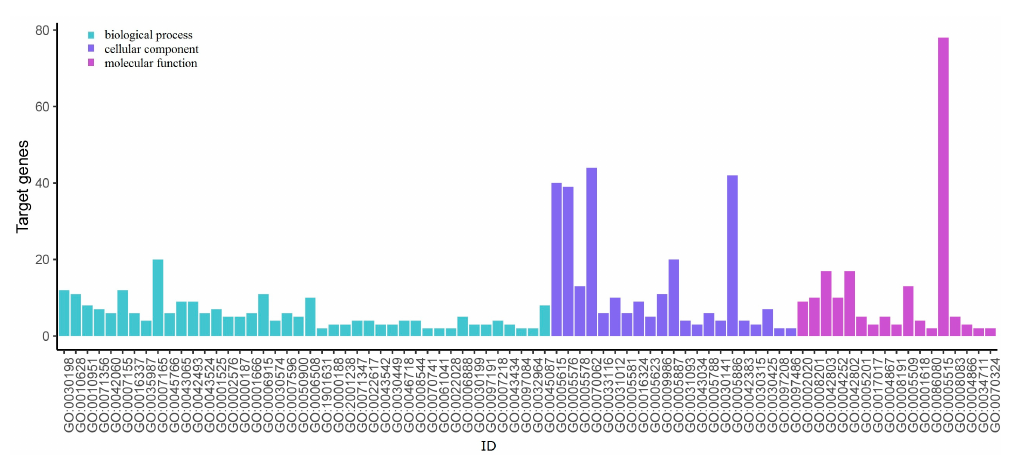
Figure 6. Down-regulated genes GO enrichment analysis.